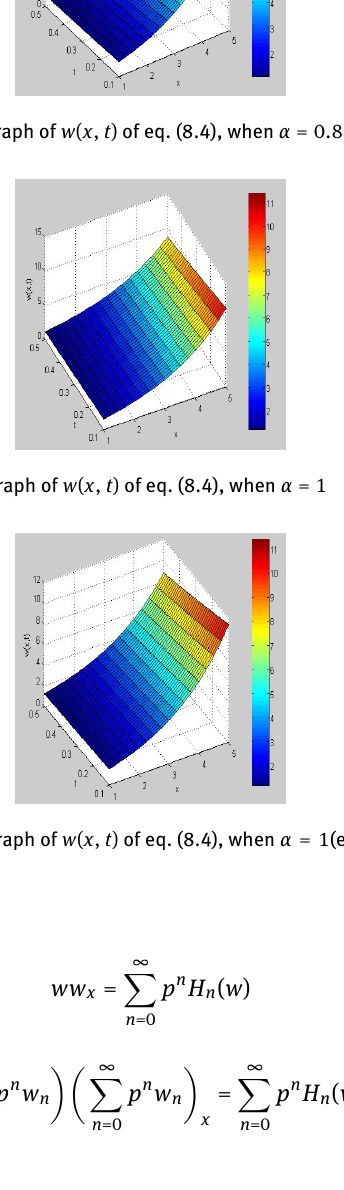
Fig. 10: Plot of of w ( x , t ) of eq. (8.4) when x = 2 and α = 0.6, 0.8 and 1